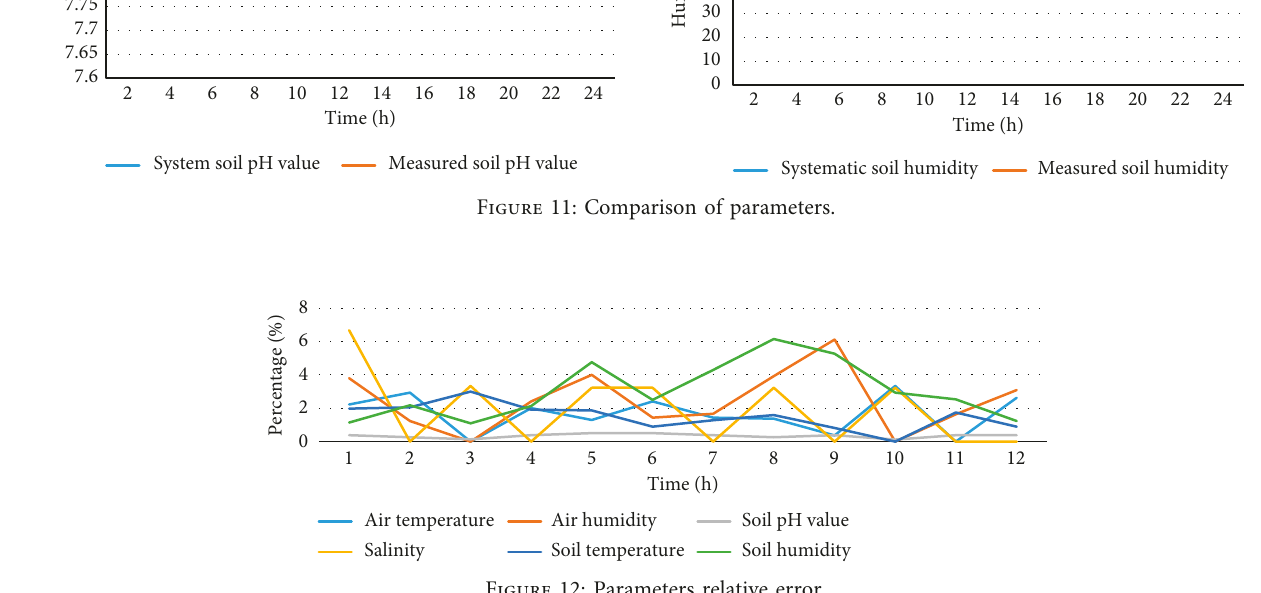
Figure 12: Parameters relative